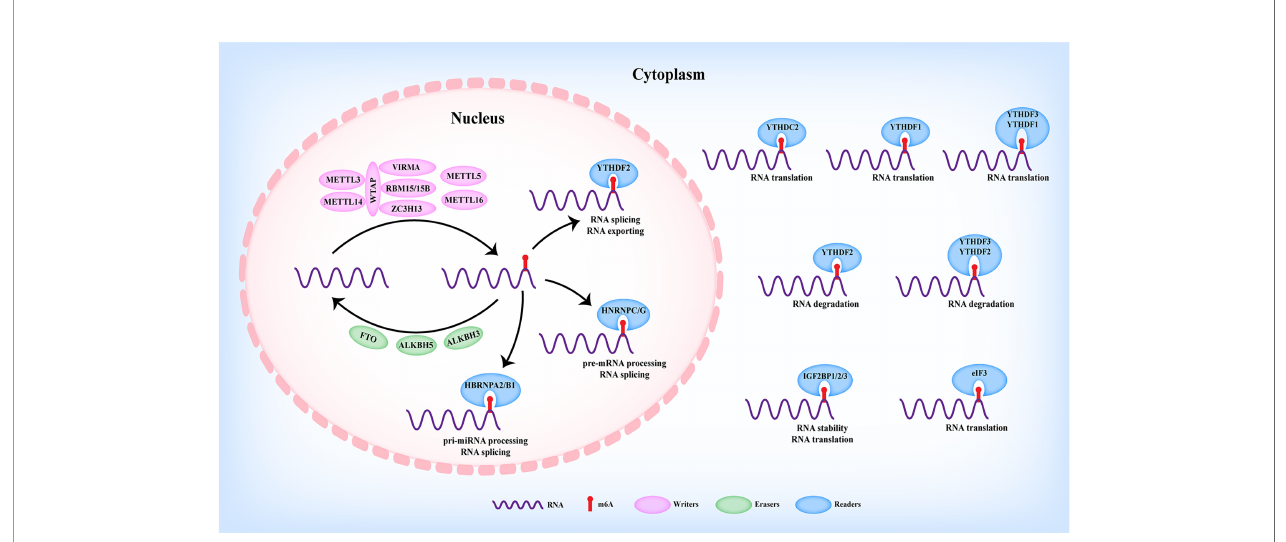
FIGURE 1 | The dynamic regulation of m6A modi fi cation in